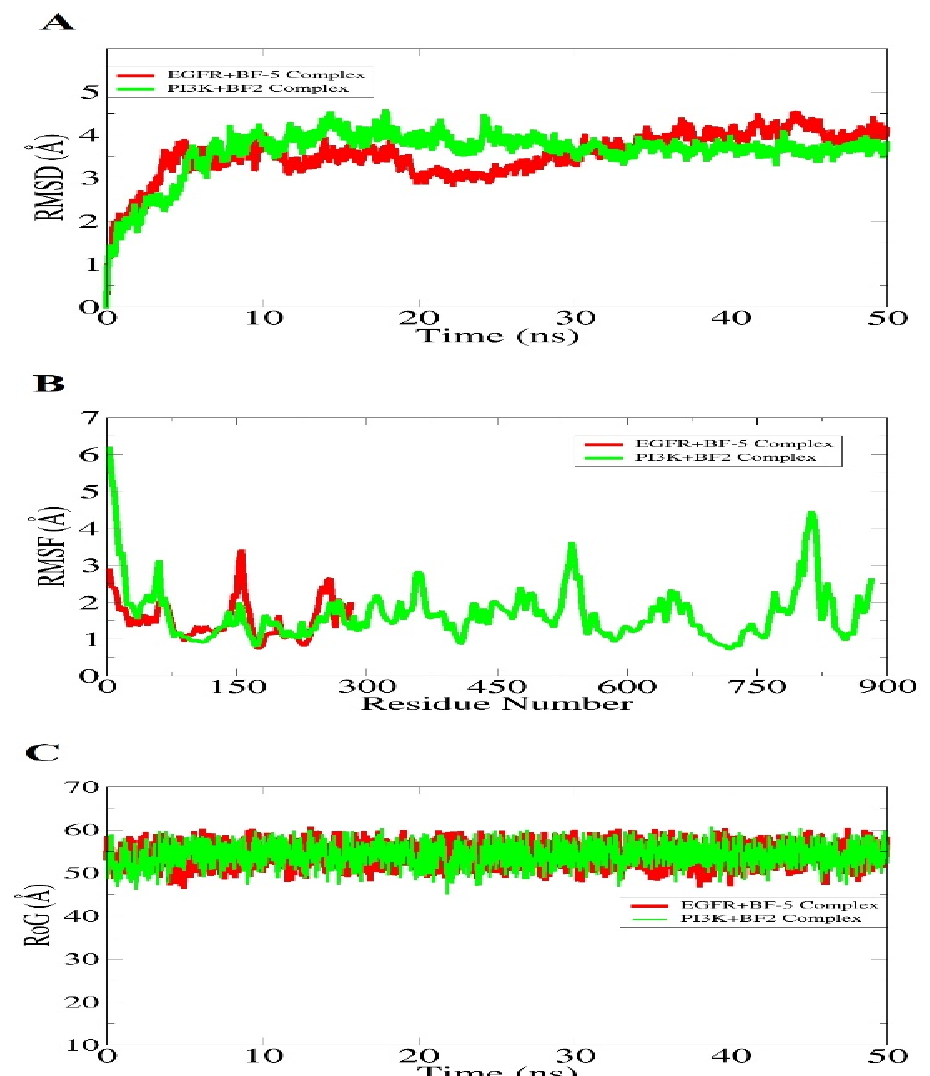
Figure 11. Simulation-based analysis of docked complexes. ( A ) RMSD ( B ) RMSF and ROG ( C ). Table 8. Binding free energies of complexes in